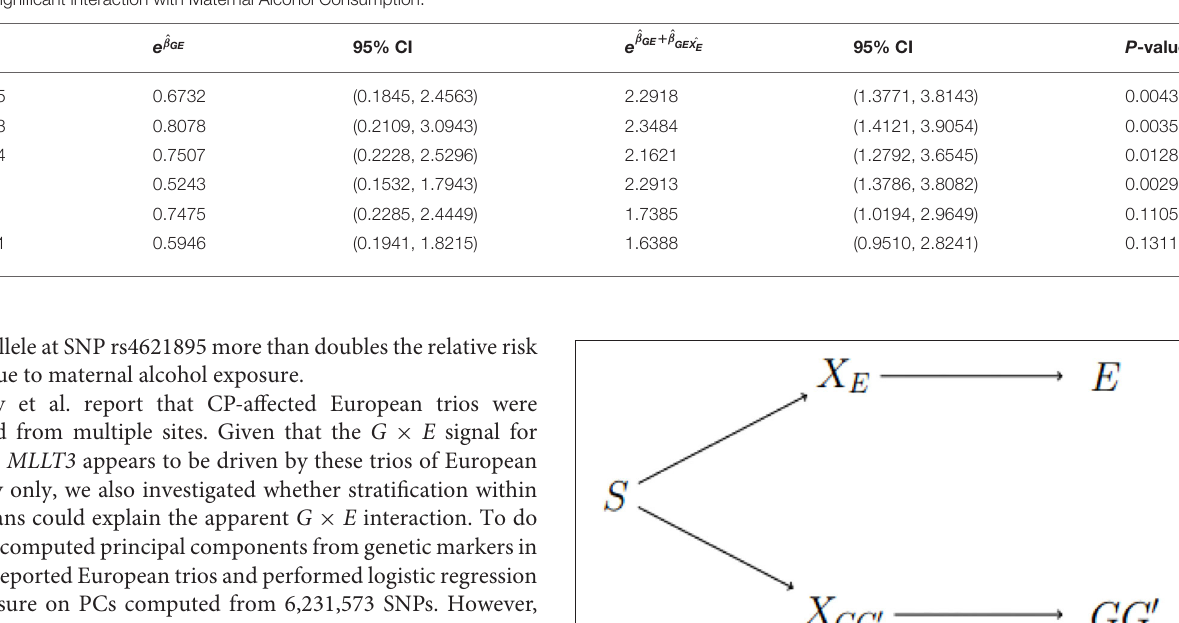
TABLE 4 | Exponentiated G × E parameter estimates with corresponding exponentiated 95% Confidence Intervals with SRA adjustment at 6 the SNPs on MLLT3 (Chr 9) showing significant interaction with Maternal Alcohol Consumption.